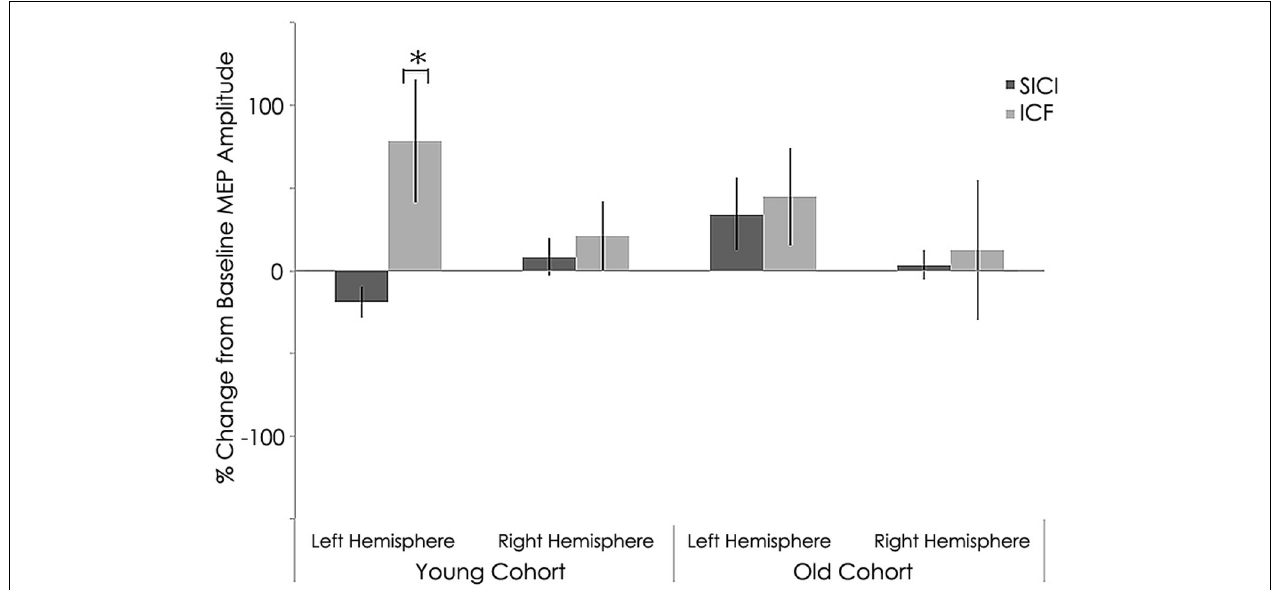
the study sample after rTMS. Statistically significant increased in in MEPs for intracortical facilitation (ICF) for left hemispheres among young subjects